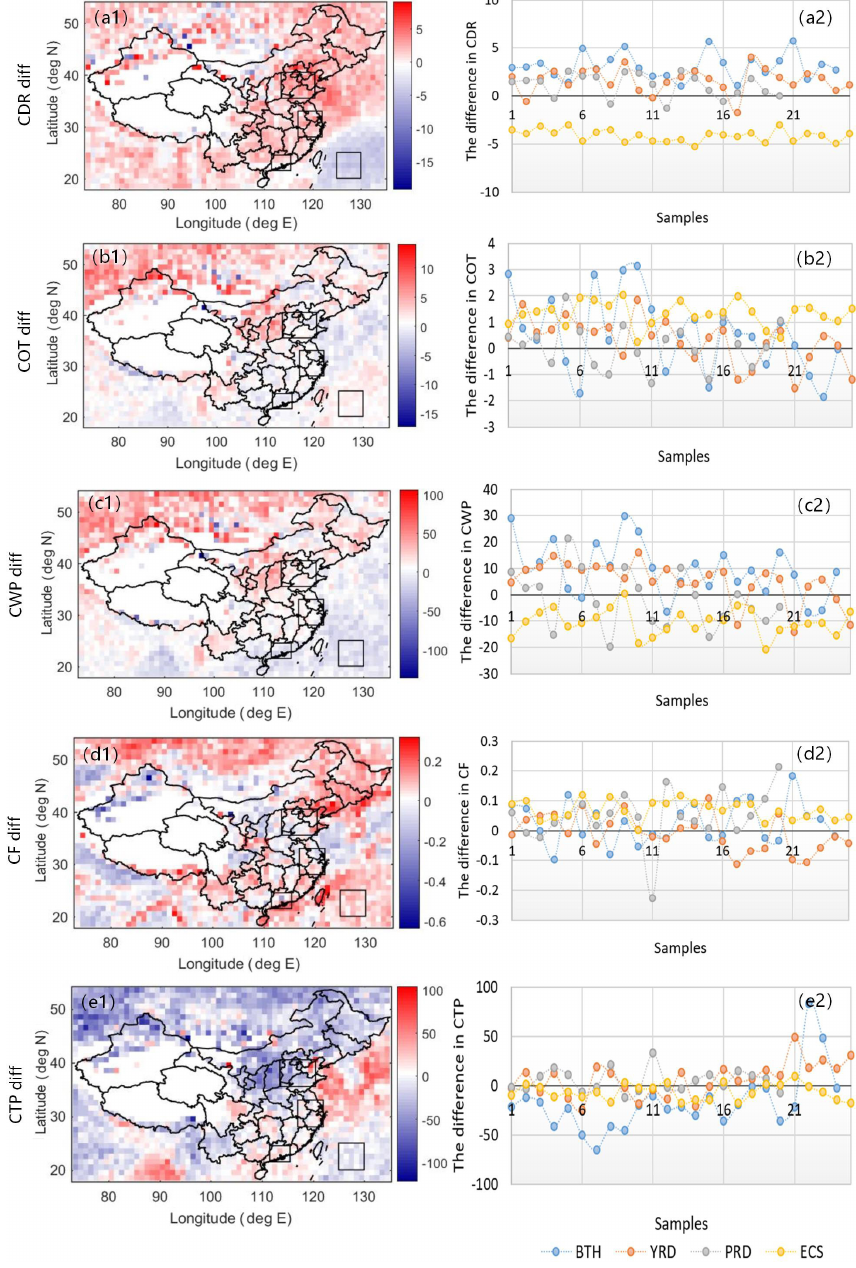
Figure 3. Spatial distribution of the differences in cloud properties (top to bottom: CDR, COT, CWP, CF and CTP) between the highest and the lowest MODIS AOD quartiles (highest–lowest) at the start time of the time step (MODIS/Terra) (left, a1–e1 ) and sample series of the differences in cloud properties (CDR, COT, CWP, CF and CTP) between the highest and the lowest MODIS AOD quartiles (highest–lowest) at the start time of the time step (MODIS/Terra) (right, a2–e2 ) over eastern China for the time period 2008–2017. See legend at the bottom for the meaning of the colors identifying the different